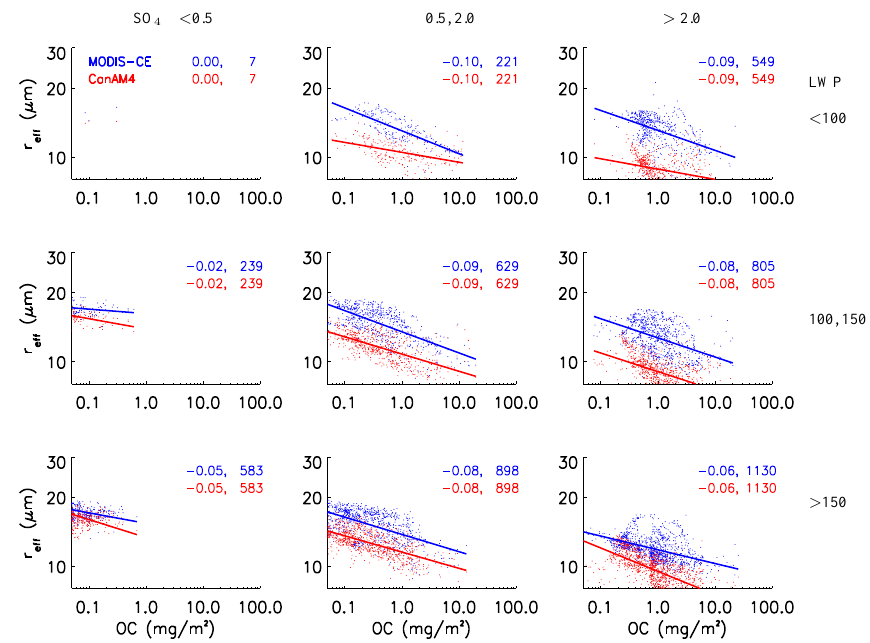
Fig. 9. Same as Fig. 5, but the simulation uses Menon’s parameterization for CDNC.